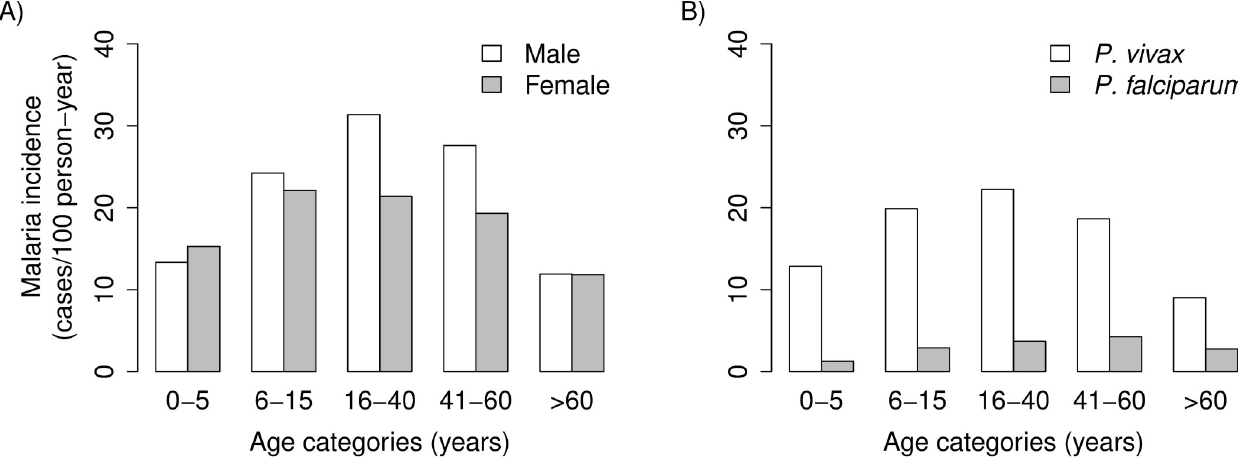
Fig 1. Age-related malaria incidence distribution in urban Maˆncio Lima, northwestern Brazil. (A) Age- and gender-related malaria incidence density, regardless of the infecting parasite species. (B) Species-specific age-related malaria incidence density.